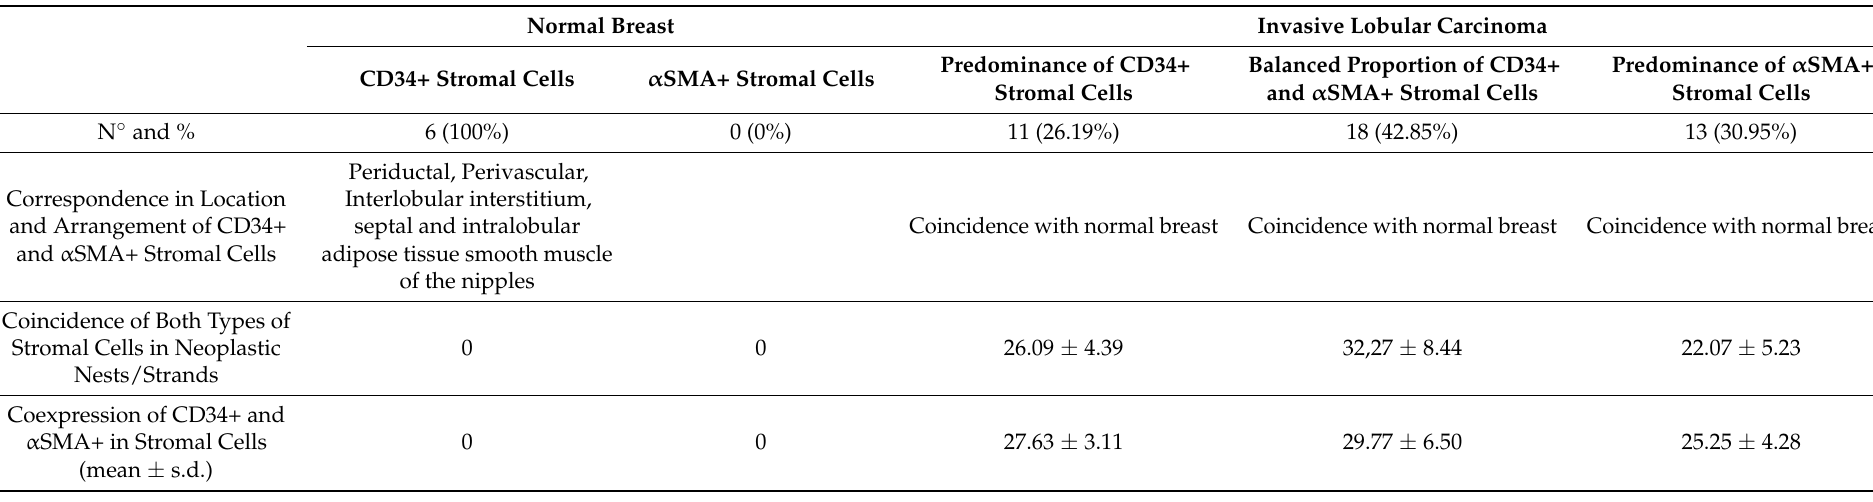
Table 2. Correspondence in location and arrangement of CD34+ and SMA+ stromal cells in the normal breast and in the stroma of invasive lobular carcinoma, the percentages of both type of cells coinciding around a same nest/strand of neoplastic cells, and the percentages of cells co-expressing both markers ( p <